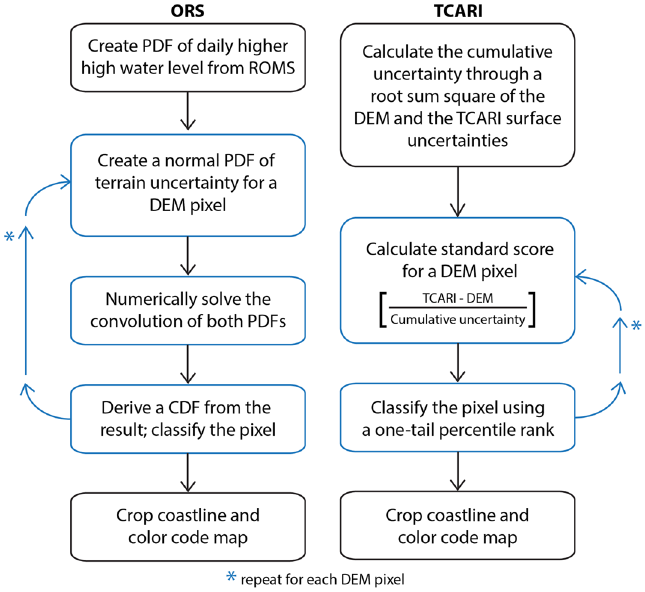
Figure 8. Data-flow diagram comparing the ORS methodology (left) to the TCARI methodology (right); blue boxes are steps to be repeated for all DEM pixels of the modeled